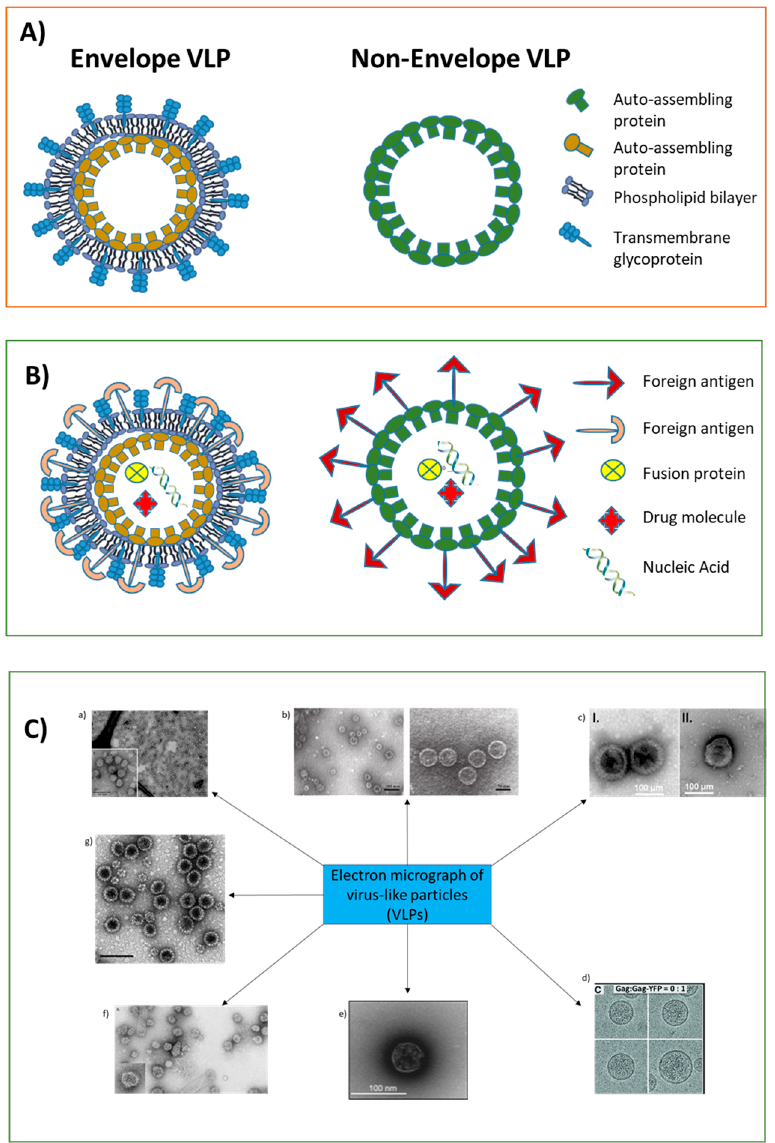
Figure 2. ( A ) Schematic structures of envelope (single layer, one protein) and non-envelope (single layer, one protein) VLPs. ( B ) Schematic structures of envelope and non-envelope VLPs as platforms for delivery of small molecules. ( C ) VLP electron microscope images. (a) HBsAg-VLPs [22]; (b) HPV-16 VLPs [23]; (c) I—KSHV virions; II—gpK8.1-based VLPs [24]; (d) HTLV-1 Gag VLPs [25]; (e) EBV-gp350/220-F VLPs [26]; (f) HCV-VLPs [27]; (g) MCPyV-VP1 VLPs